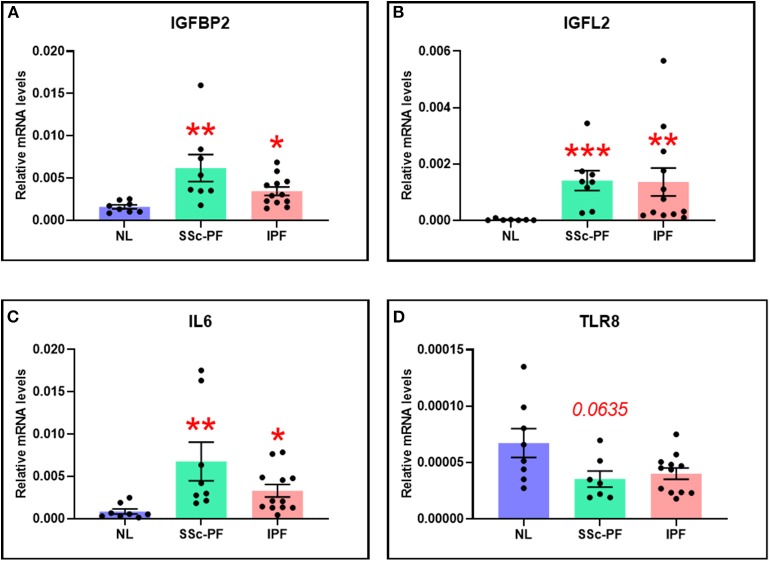
The expression levels of (A) IGFBP2, (B) IGFL2, (C) IL6, and (D) TLR8 were quantified in tissue lysates from SSc-PF (n = 8) and IPF (n = 12) patients and healthy individuals (NL, n = 8). *p < 0.05, **p < 0.01, ***p < 0.001 vs. NL. Error bars = SEM.